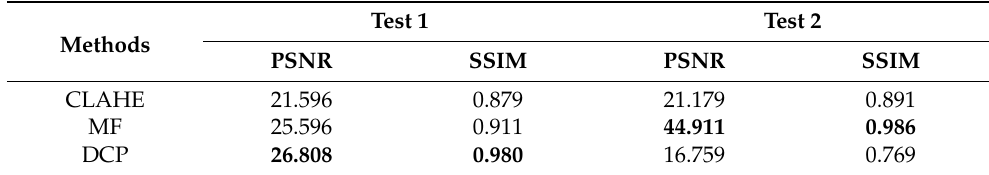
Table 3. PSNR and SSIM calculated values for the CLAHE, MF, and DCP methods.